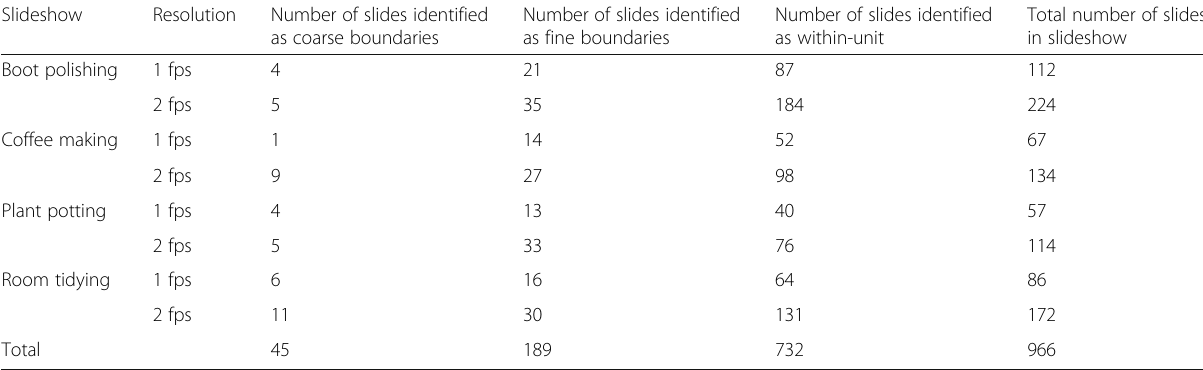
Table 1 Number of coarse and fine boundaries and within-unit slides for 1-fps and 2-fps versions of each slideshow Slideshow Resolution Number of slides identified Number of slides identified as coarse boundaries as fine